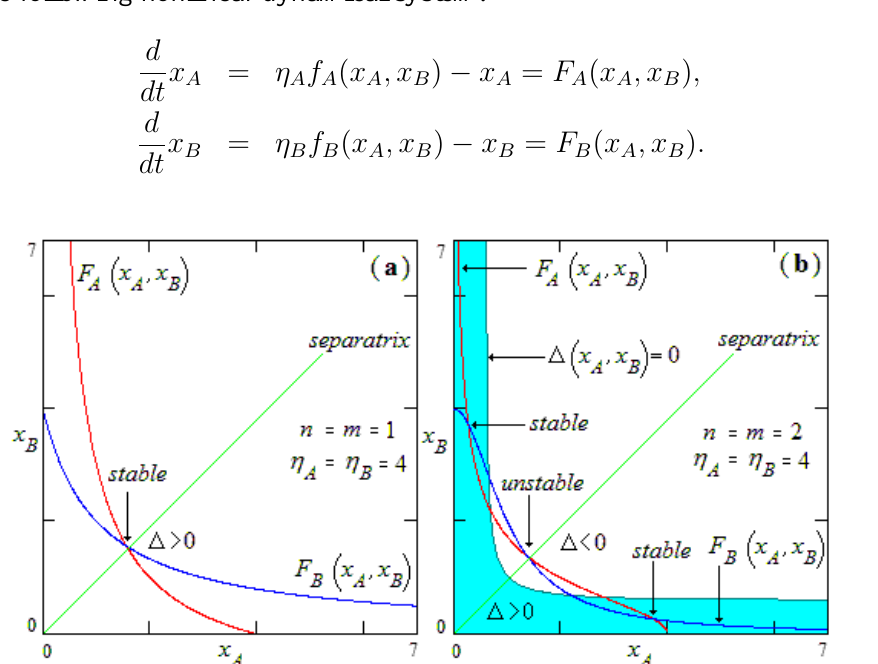
Figure 1: Geometrical structure of the mean-field model of the genetic toggle switch: (a) the monomer case; (b) the multimer